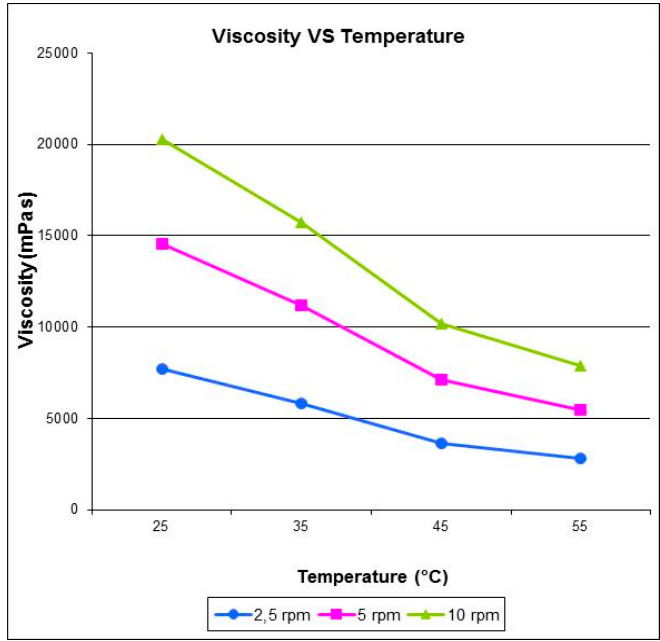
Figure 5. Caesalpinia spinosa gum viscosity at different temperatures.